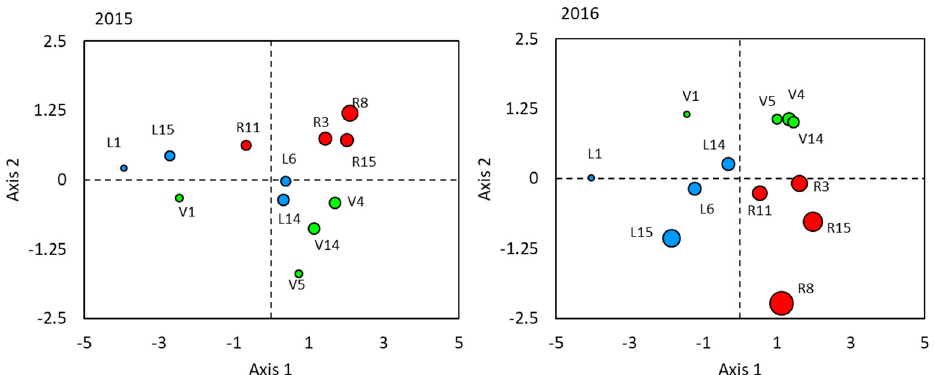
Figure 8. DAPC results with the circle size depicting variation in chlorophyll content from Dualex chlorophyll index (the bigger the circle, the higher the chlorophyll content). Symbols are centroids for genotype colored according to the provenance (Loppi (L, 60° N, southern Finland), Vehmersalmi (V, 62° N, central Finland), and Rovaniemi (R, 66° N, northern Finland)).